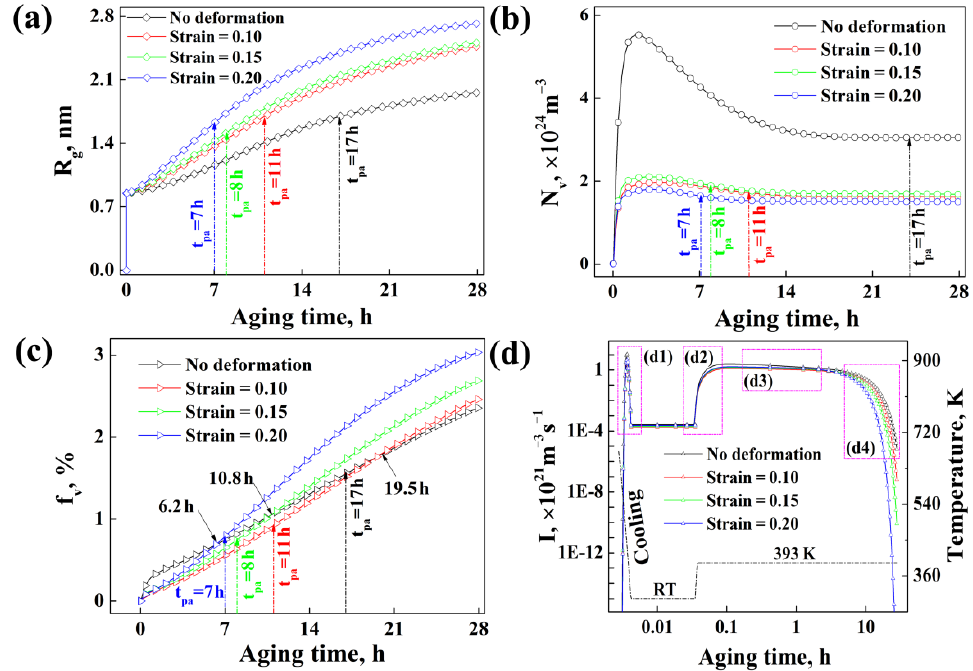
Figure 9. Average radius, number density, volume fraction and evolution of nucleation rate of precipitates changed with aging time for the alloy samples with different strains: ( a ) average radius; ( b ) number density; ( c ) volume fraction; ( d ) evolution of nucleation rate.